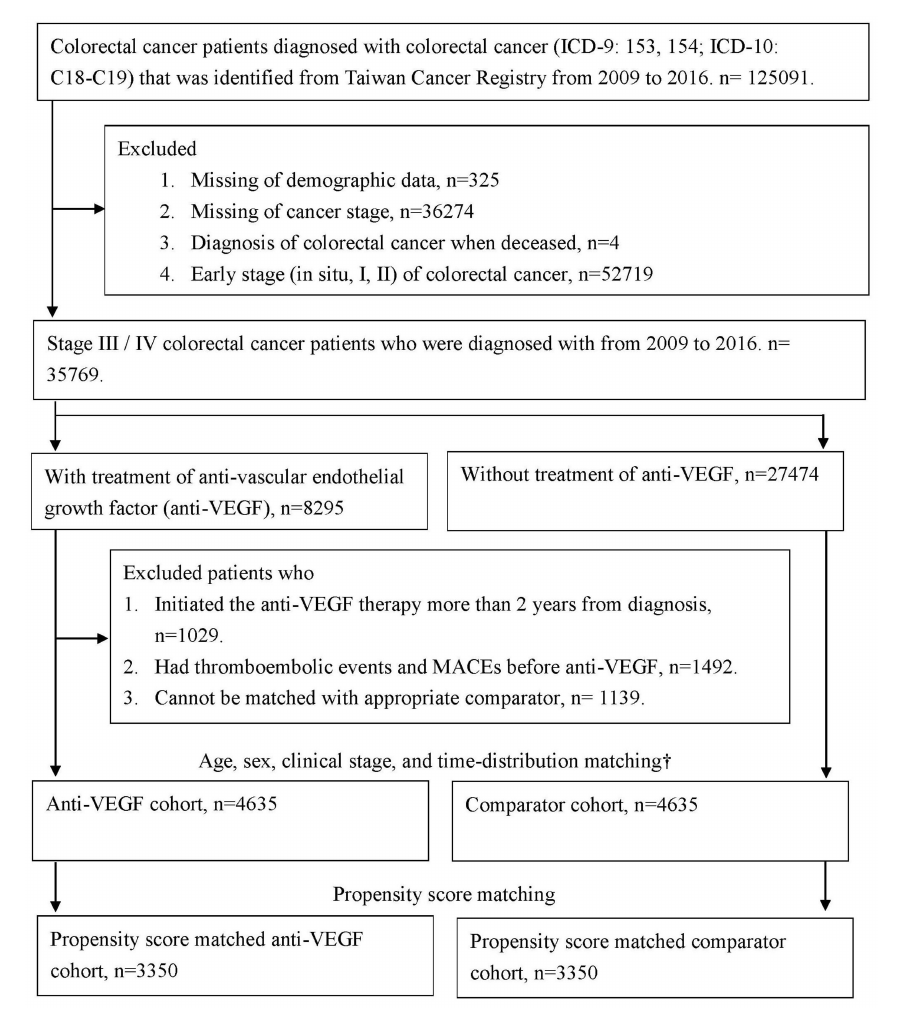
Figure 1. Flow chart of selected colorectal cancer patients who were treated with anti-vascular endothelial growth factor (anti-VEGF) and the comparator cohort. † Age, sex, clinical stage, and time-distribution matching was used to deal the immortal time bias, the comparators, who were matched with anti-VEGF patient by age, sex, clinical stage, and diagnosis date, and at risk on the index date (comparator’s index date was the same as the paired anti-VEGF patient). Abbreviation: MACEs, Major cardiovascular events; anti-VEGF, anti-vascular endothelial growth